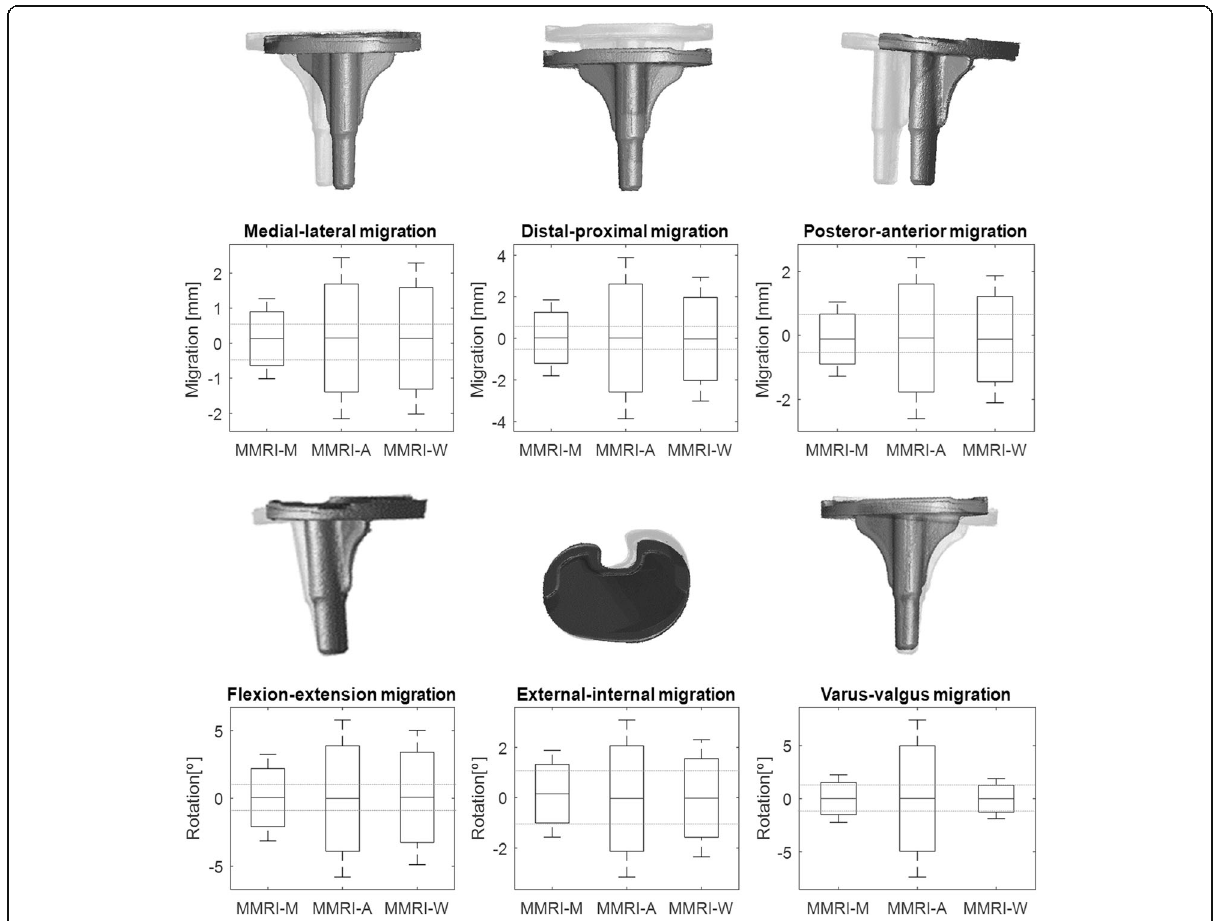
Fig. 4 Boxplots for the six degrees of freedom, three for translation and three for rotation, for MMRI-M, MMRI-A and MMRI-W (95% CI; μ ± 2 σ ). The dashed horizontal lines indicate bounding range of RSA accuracy reported in